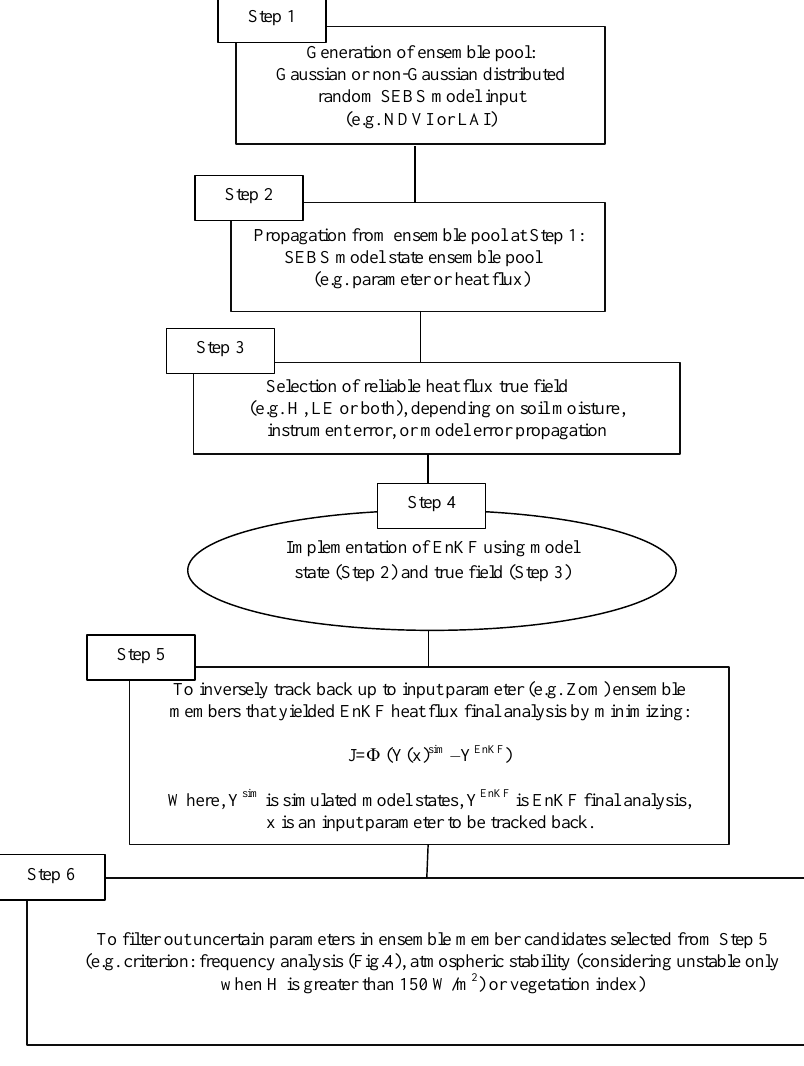
Fig. 2. Conceptual diagram for determination of aerodynamic roughness via Fig.2.Conceptual diagram for the determination of roughness via EnKF